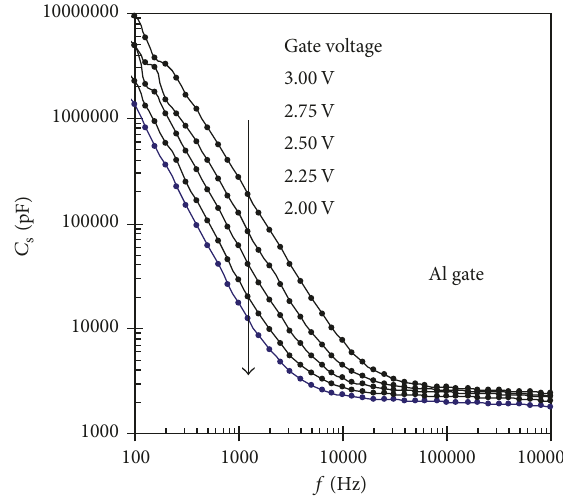
Figure 2: 𝐶 - f characteristics in the case of an Al s